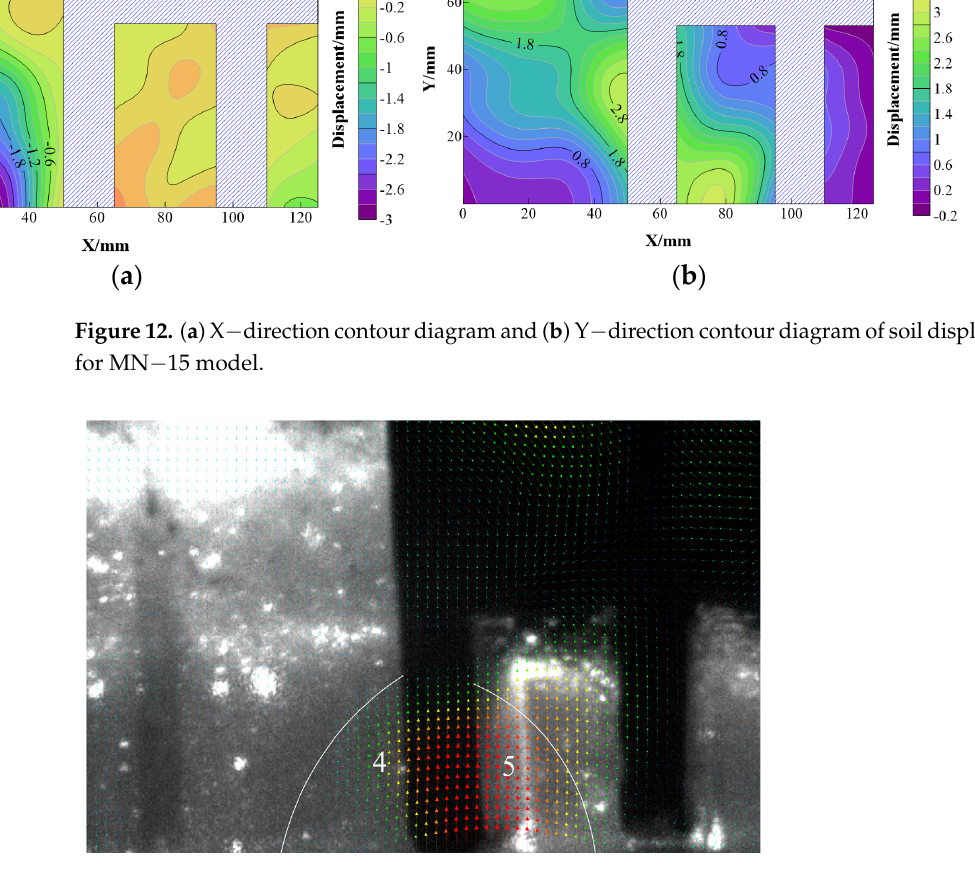
Figure 13. Vector diagram of soil displacement for MP − 15 model.